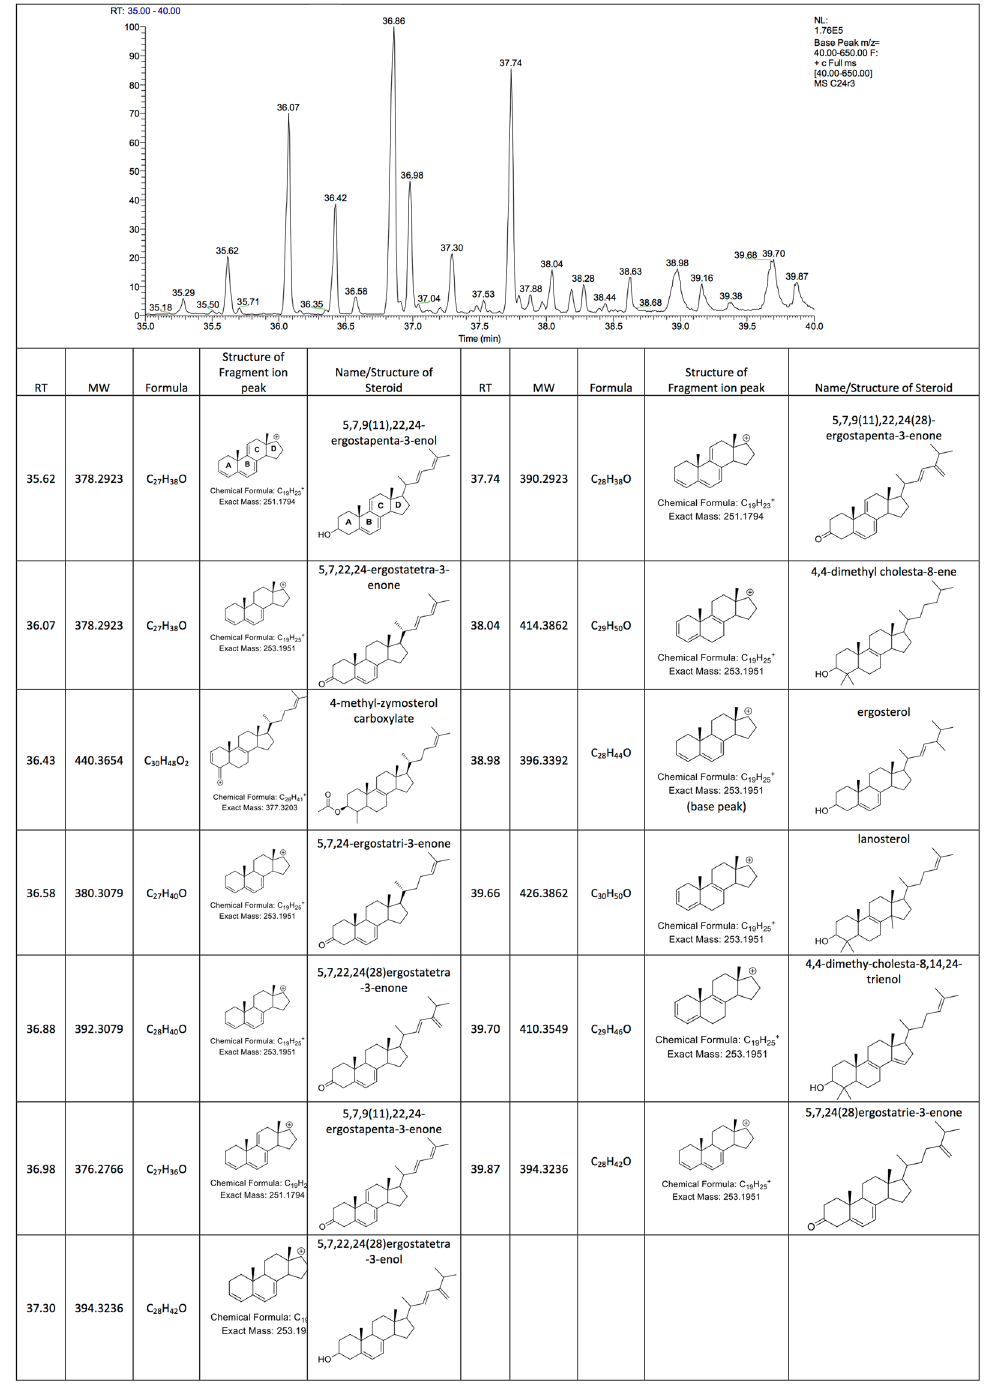
Figure 1. Ion chromatogram demonstrating the principal sterols of Acanthamoeba (clinical T4 strain), their retention times (RT), molecular weights (MW) with observed base peaks, chemical formulae, names and structures. The structures on column 4 represent the ‘fragment ion peak’, while the structure on column 5 represent the ‘molecular ion peak’. The fragment ion peak is the base peak which confirms the positions of the double bonds on rings B and C, this information is combined with the molecular ion peak to elucidate the complete